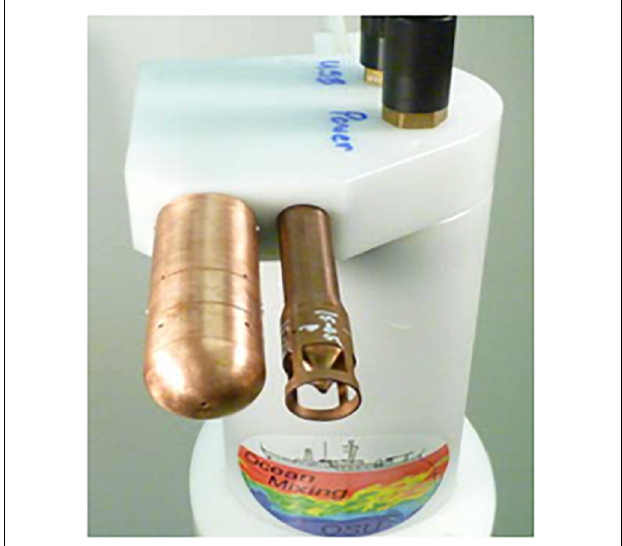
FIGURE 2 | A Chi-Pod package configured for moored deployment (Courtesy Jim Moum,